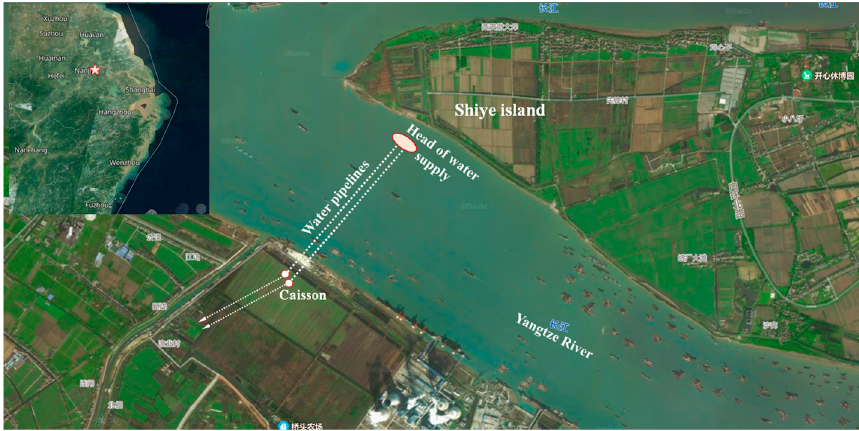
Figure 1. The location of the Jurong Yangtze River water intake project.